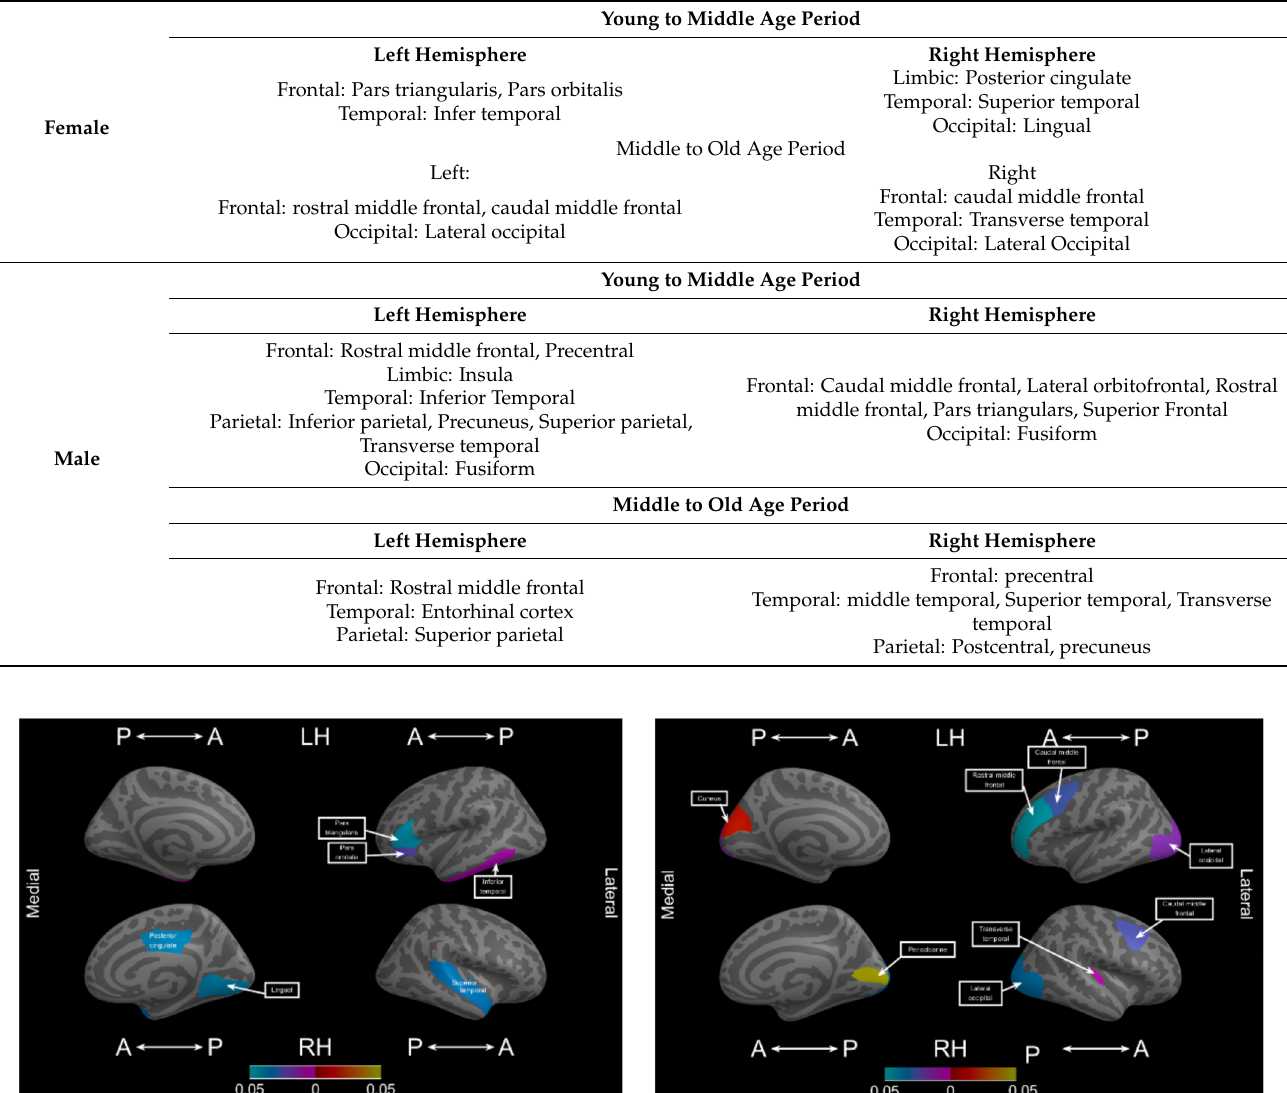
Table 6. Significant changes in cortical subregions at two different age periods for men and women.